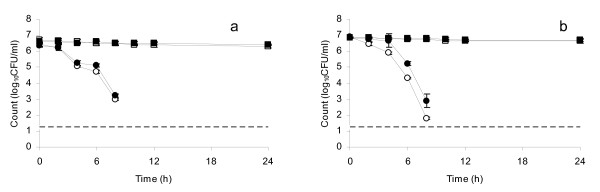
Plate counts of (a) S. Typhi 733 and (b) S. Typhi Ty2 in distilled water at pH 7.0, 30°C stored in a copper vessel and enumerated under aerobic conditions (open circles) and ROS-n conditions (closed circles); (a) S. Typhi 733 and (b) S. Typhi Ty2 in distilled water at pH 7.0, 30°C stored in a glass vessel and enumerated under aerobic conditions (open squares) and ROS-n conditions (closed squares) Error bars represent 95% confidence limits (n = 3). No counts were obtained at 24 h under any conditions. No counts were obtained after 8 h for bacteria kept in water in the copper vessel.